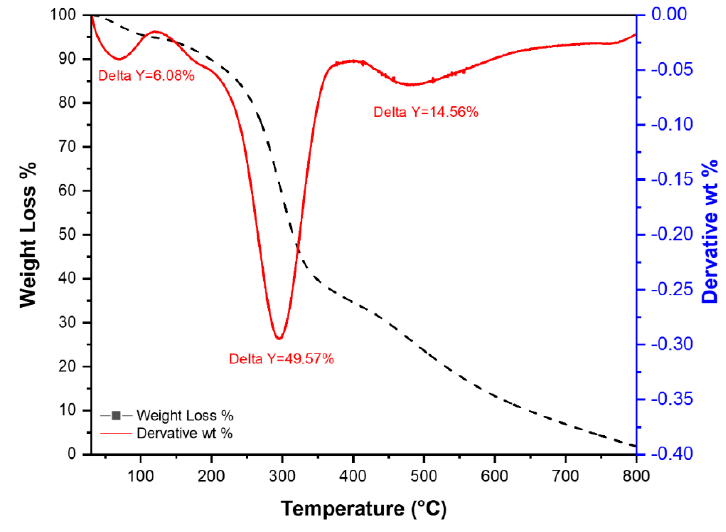
Figure 4. TGA graph of air—dried pineapple leaves (RPAL).